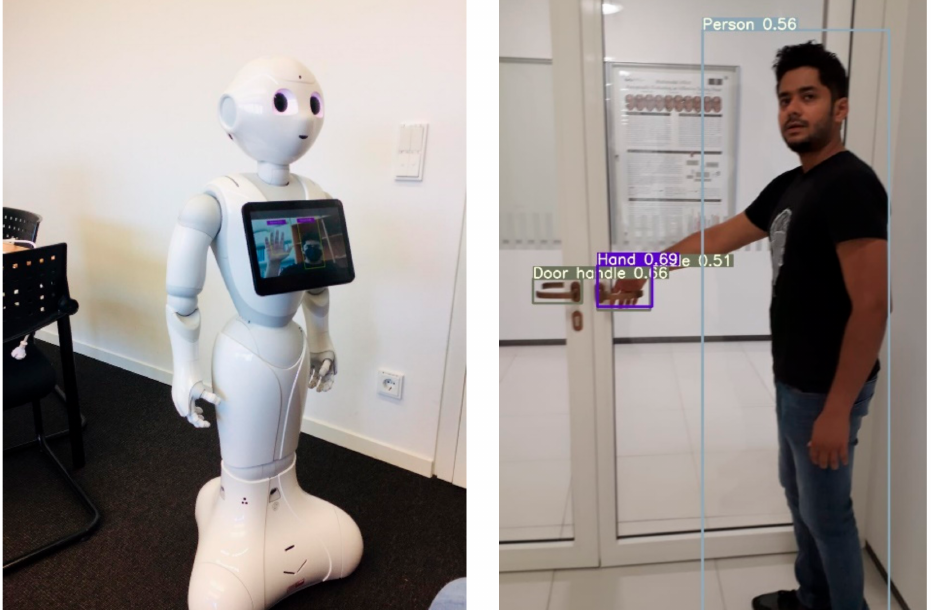
Figure 5. Detection of people inside a room. This figure contains two panels in which we show our Pepper robot equipped with an on-robot tablet, running Android OS, on the left. Our application run- ning yolov5 for door handle detection and person detection runs on the tablet that can communicate with one of the on-robot cameras. The panel on the right shows multiple object detection with neural network yolov5 in action. The bounding boxes on the right panel seem to overlap as the objects are almost in the same position, i.e., door handles and the hand of the person holding the knob with accuracies of 0.66, 0.51, and 0.69, respectively. The accuracy tends to decrease as the small object detection usually becomes difficult for such networks. As the robot approaches the object, the object in the perspective of the camera will be detected with a greater accuracy, as also shown in Figure